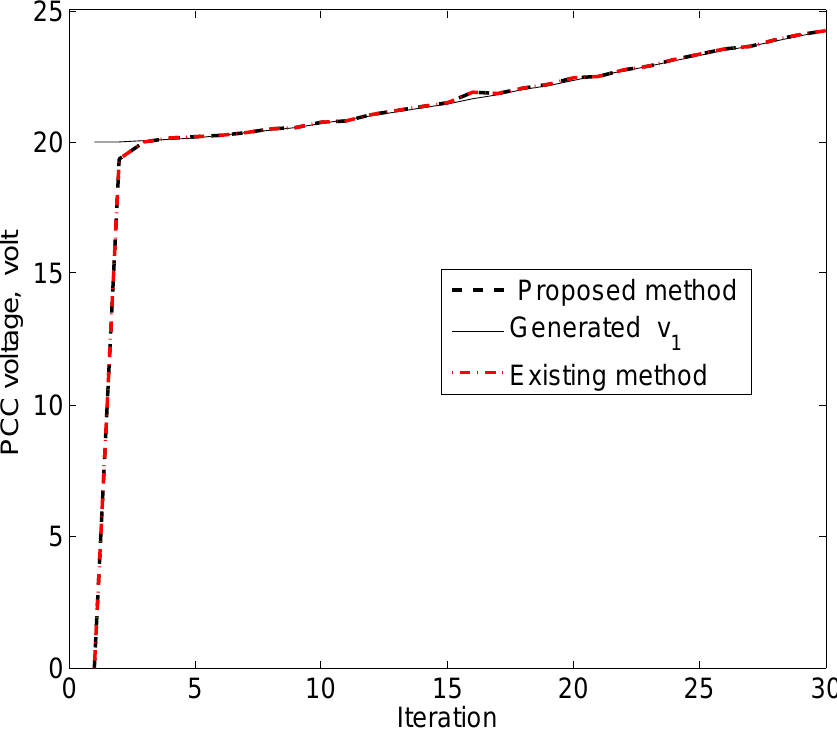
Figure 11. Point common coupling (PCC) voltage estimation for v